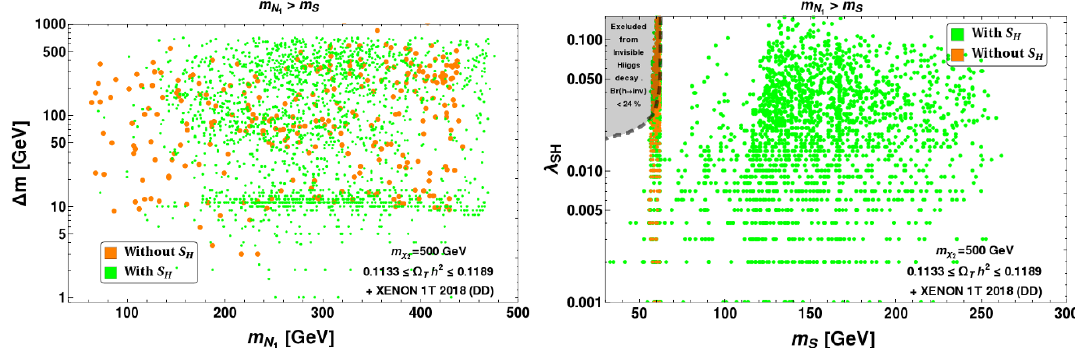
Figure 18 . Relic density and direct search (XENON 1T [10]) allowed parameter space of the two component model compared between two cases: (i) original model, in absence of the heavy scalar ( S H ) (orange points) and (ii) in presence of a heavy scalar ( S H ) (green points) in m N (left) and m S (cid:21) SH plane (right). (cid:0)